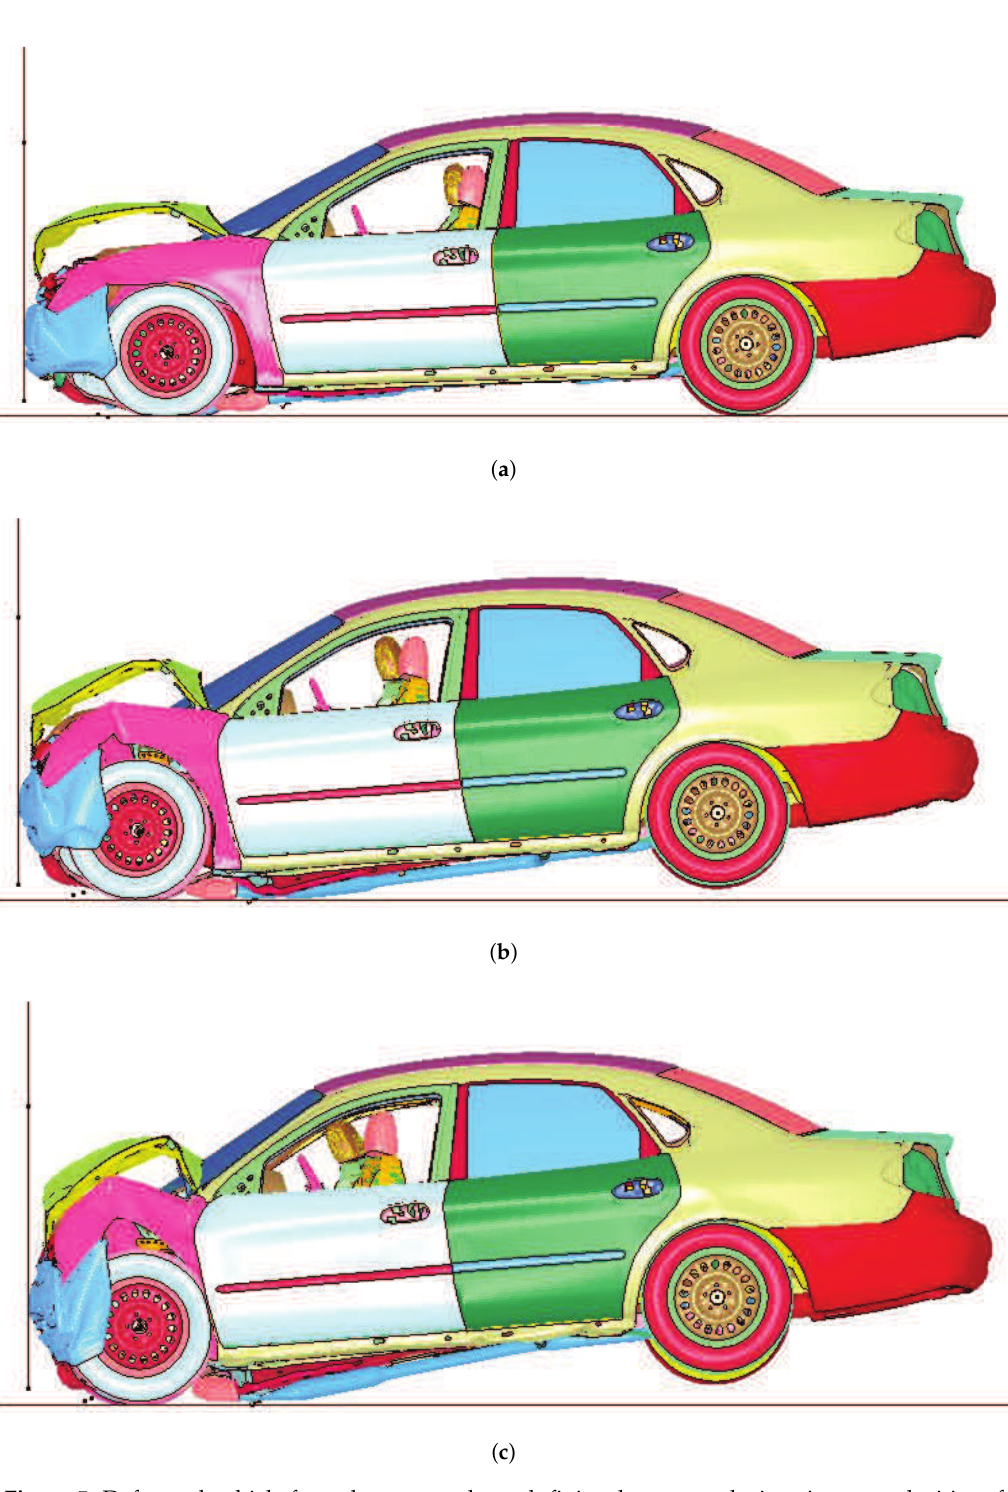
Figure 5. Deformed vehicle frontal structure through finite element analysis at impact velocities of ( a ) 40 km/h; ( b ) 56 km/h; and ( c ) 72 km/h. The kinematic time-history (displacements, velocities, and accelerations) are compared as shown in Figures 7 and 8. These Figures show the predictions of the LPM for a range of velocities (40, 48, 56, 64, and 72 km/h, respectively). Figure 9 presents a summary of kinematics results of the LPM calibrated at 56 km/h against the FSCT and FEA,